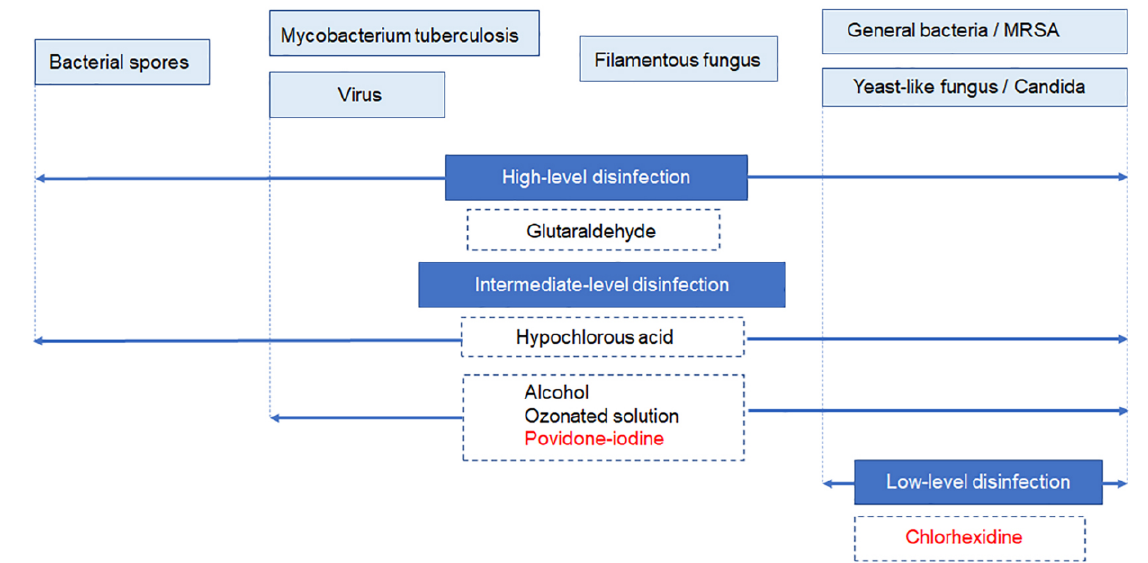
Figure 5. Three levels of disinfectants classified according to features including difference in antimicrobial spectrum. High- level disinfectants are used for disinfecting instruments. Among the intermediate-level disinfectants, only povidone-iodine has the established safe concentration for ocular tissues. Among the intermediate-level agents, chlorhexidine is used in intravitreal injection. However, since the safe concentration for intraocular tissues has not been established, chlorhexidine cannot be used for intraoperative irrigation of the ocular surface. (Authors’ unpublished image).